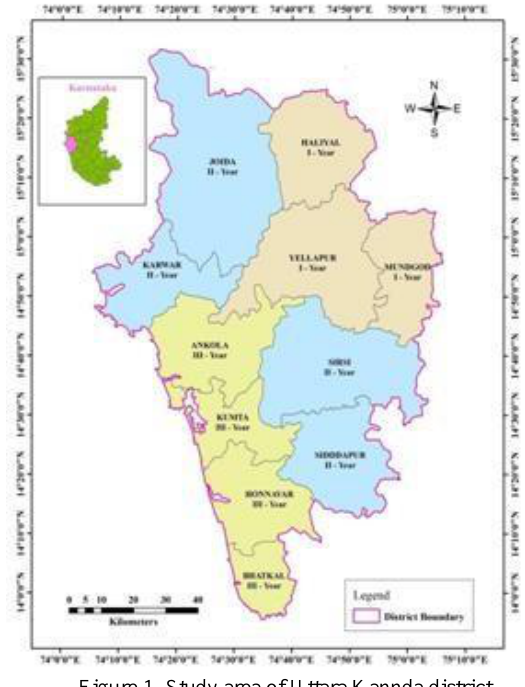
Figure 1. Study area of Uttara Kannda district.